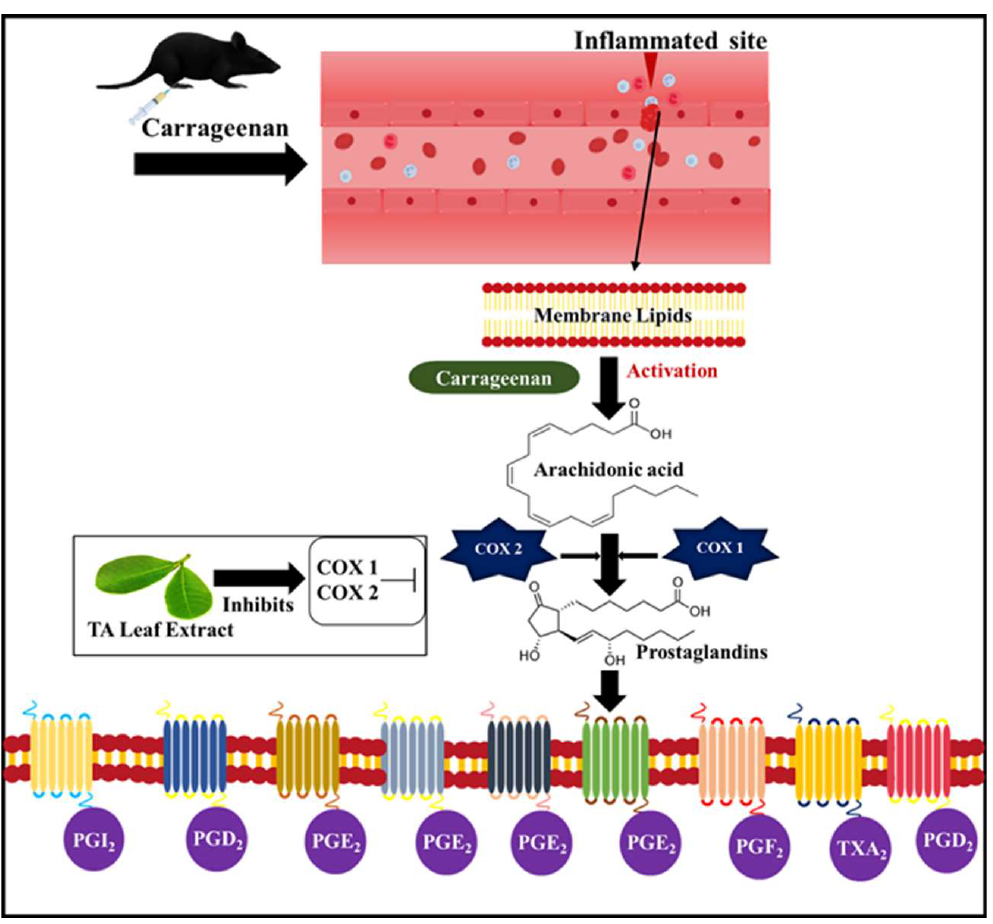
Figure 3. Anti-inflammatory mechanism of action of TA extract on Carrageenan-induced paw edema.